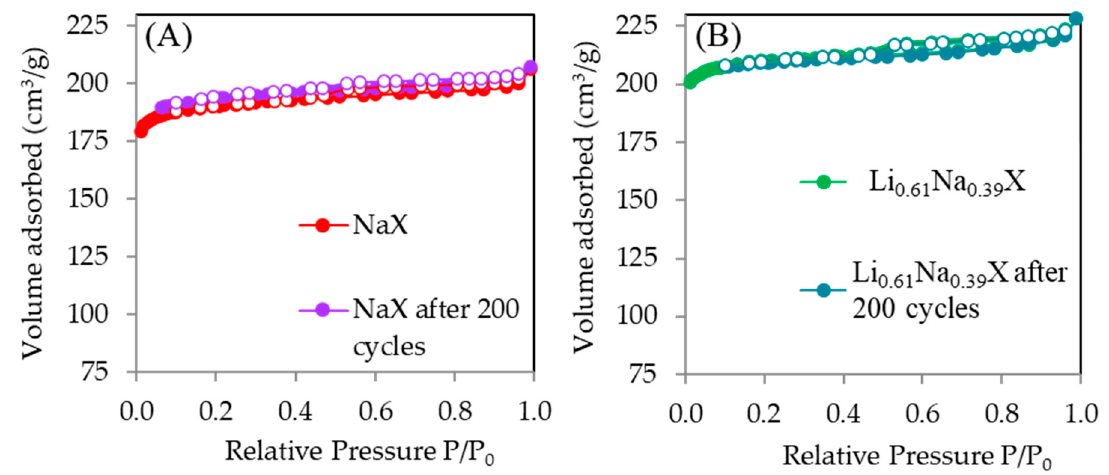
Figure 15. N 2 adsorption/desorption isotherms of particular zeolites before and after aging tests: ( A ) NaX, ( B ) Li 0.61 Na 0.39 X. Table 8. Textural properties of the zeolites before and after aging tests.